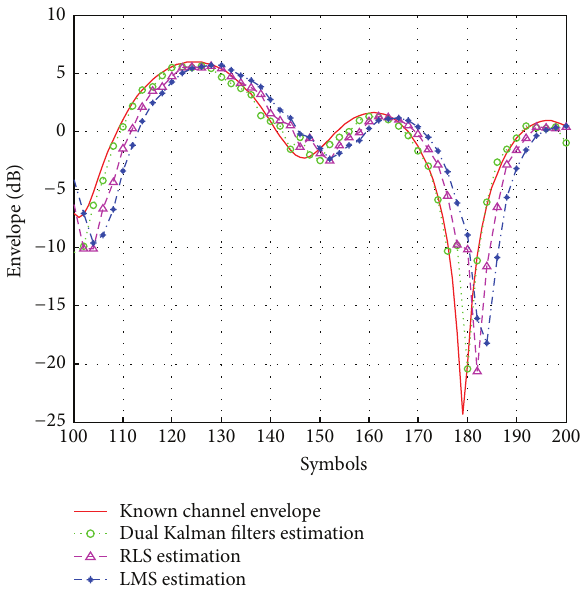
Figure 6: BER performance versus SNR for the FBMC/OQAM system with the various channel estimators. 𝑀 = 2048 , 𝑁 𝑝 = 1024 , and 𝑓 𝑑 𝑇 𝑠 = 0.0167 .